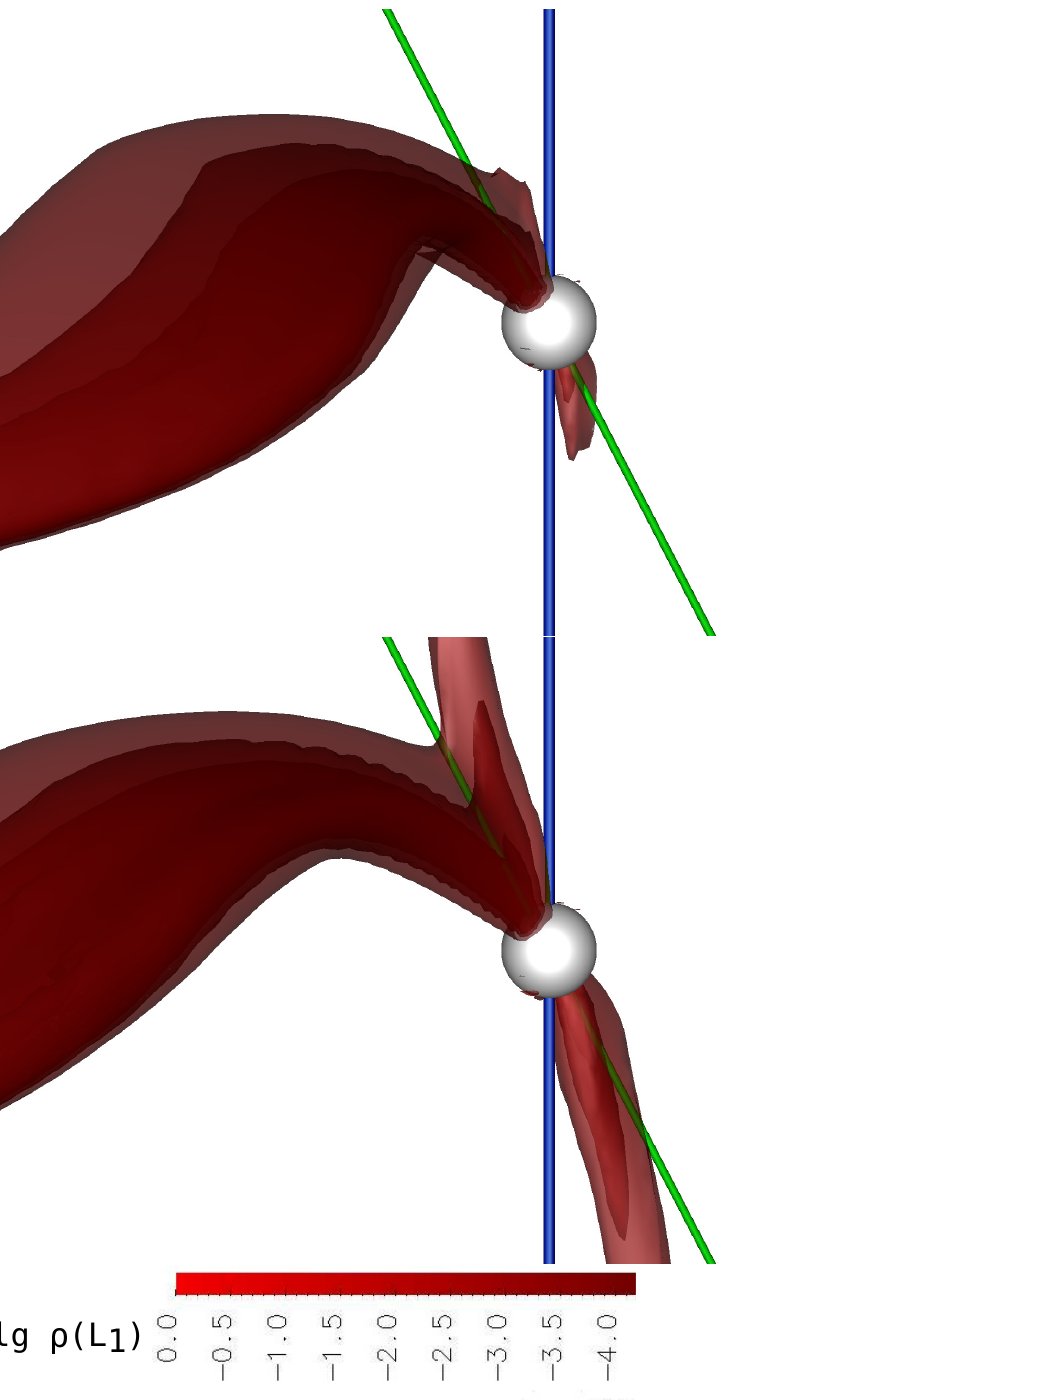
Figure 3. The same as Figure 2, but for Model 3 ( upper panel) and Model 4 ( lower panel). The binary system is shown from the point of view of an Earth observer at the orbital phase